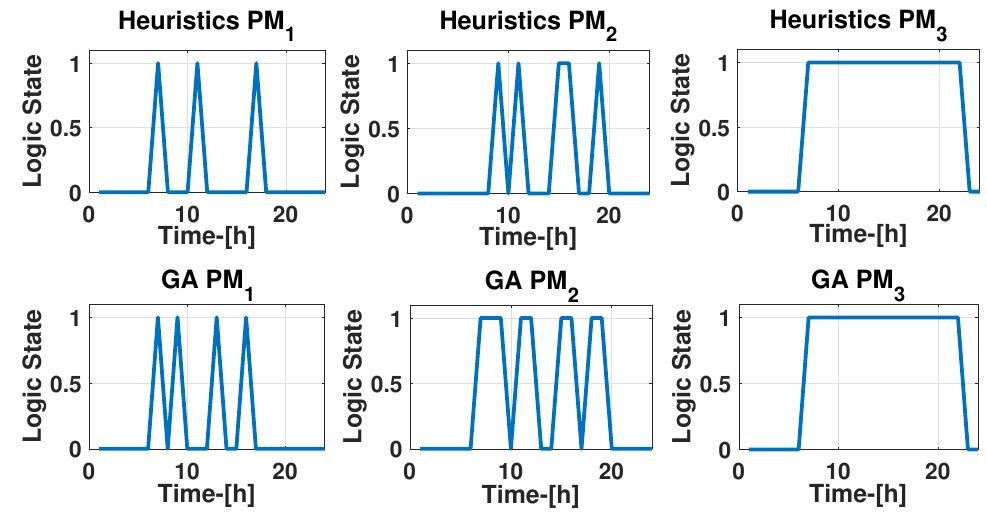
Figure 15. Heuristics and GA water pumps’ numerical